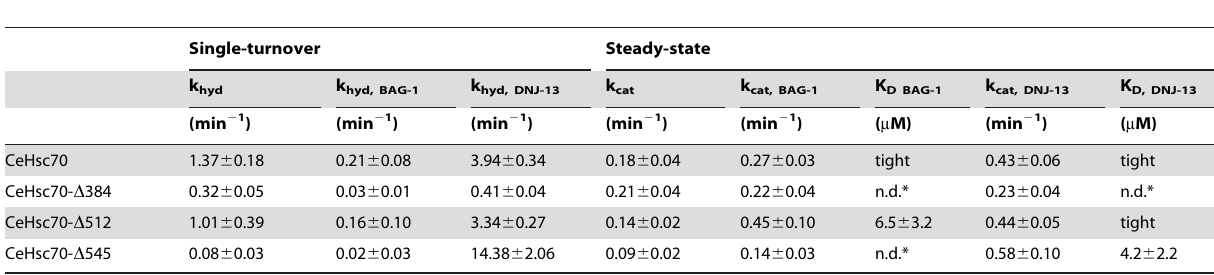
Table 2. Enzymatic parameters of cofactor interactions with lid domain